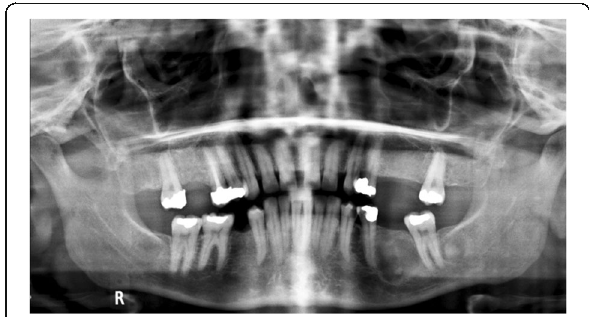
Fig. 2 On the orthopantomogram (OPG), there is a single well-defined, corticated, lucent lesion in the body of the left mandible between the premolar and only remaining molar tooth